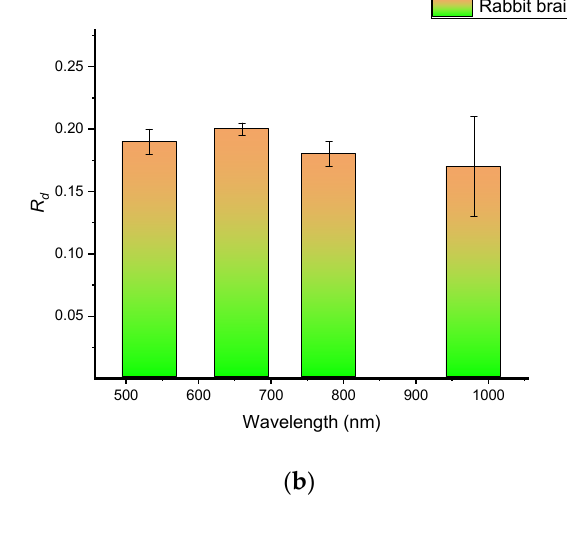
Figure 6. Finite element mesh and geometry for the fluence rate determination.